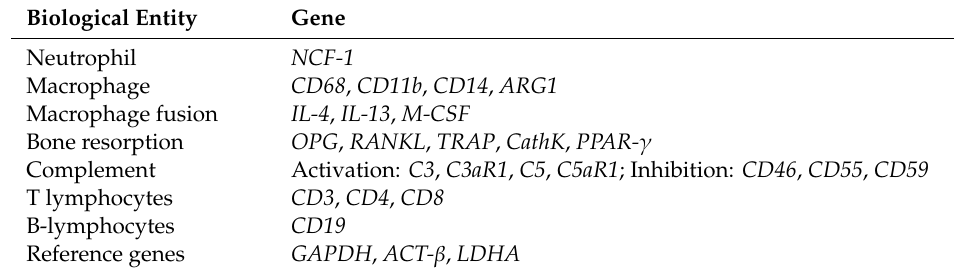
Table 2. Correspondence between studied gene expression and biological